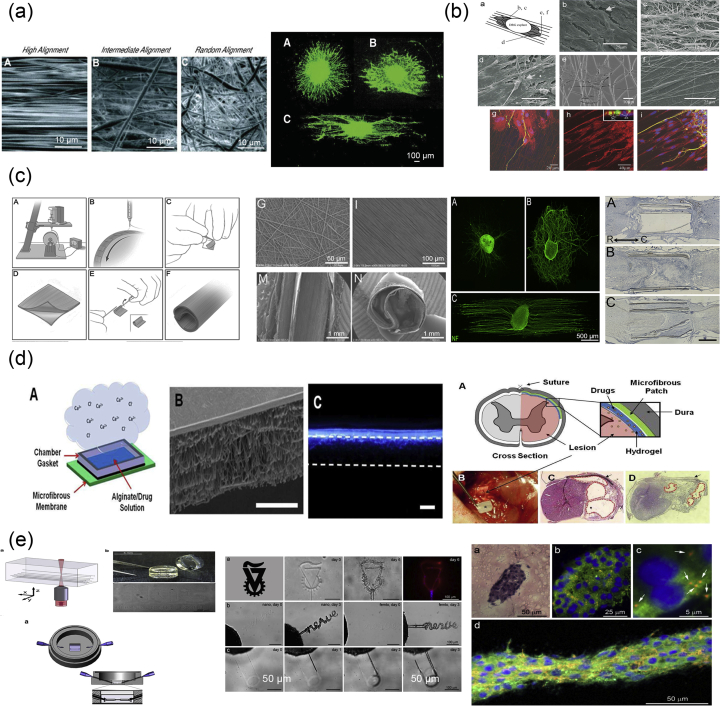
Different methods for fabricating scaffolds to support spinal cord regeneration after injury. (a) Aligned electrospun nanofibers that support and direct the growth of DRGs [195], (b) aligned electrospun nanofibers made of biodegradable PCL/collagen blends for nerve regeneration [197], (c) fabrication of conduits from electrospun PLA fibers that support CNS tissue growth [202], (d) drug-eluting microfibrous patches for local delivery of rolipram in spinal cord repair [204], and (e) patterned microchannels created by laser photoablation guide the directional growth of neurites from dorsal root ganglia [206]. Images adapted with permission from (a) Corey et al. ​[195], (b) Schnell et al. ​[197], (c) Hurtado et al. ​[202], (d) Downing et al. ​[204], and (e) Sarig-Nadir et al. ​[206]. DRG, dorsal root ganglion; PCL, polycaprolactone; PLA, polylactic acid; CNS, central nervous system.